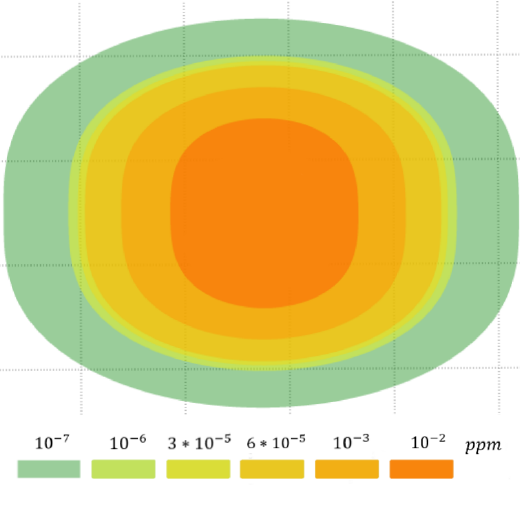
Figure 1. Typical characteristics of a heavy gas